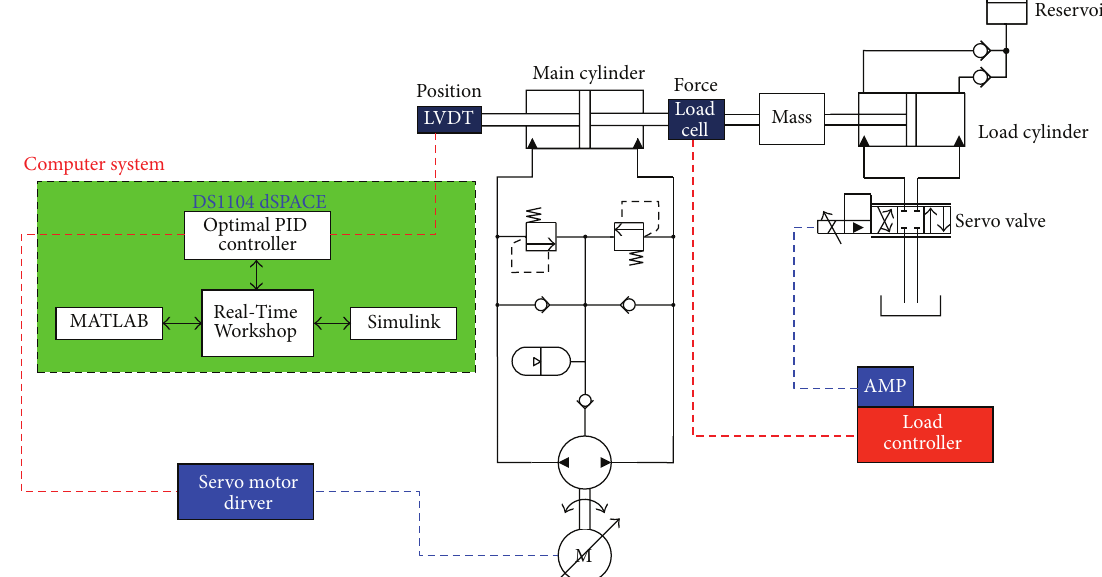
Figure 2: Schematic diagram for the test rig of the EHA prototype.